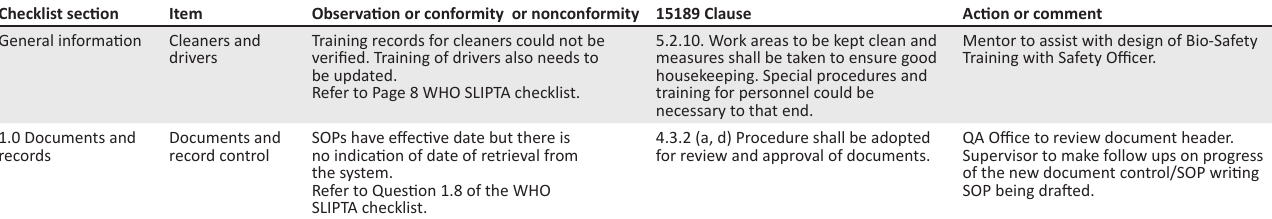
TABLE 2: Example summary of assessment findings table formulated after each assessment to be used by the laboratory and mentor to generate action plans. Checklist section Item General information